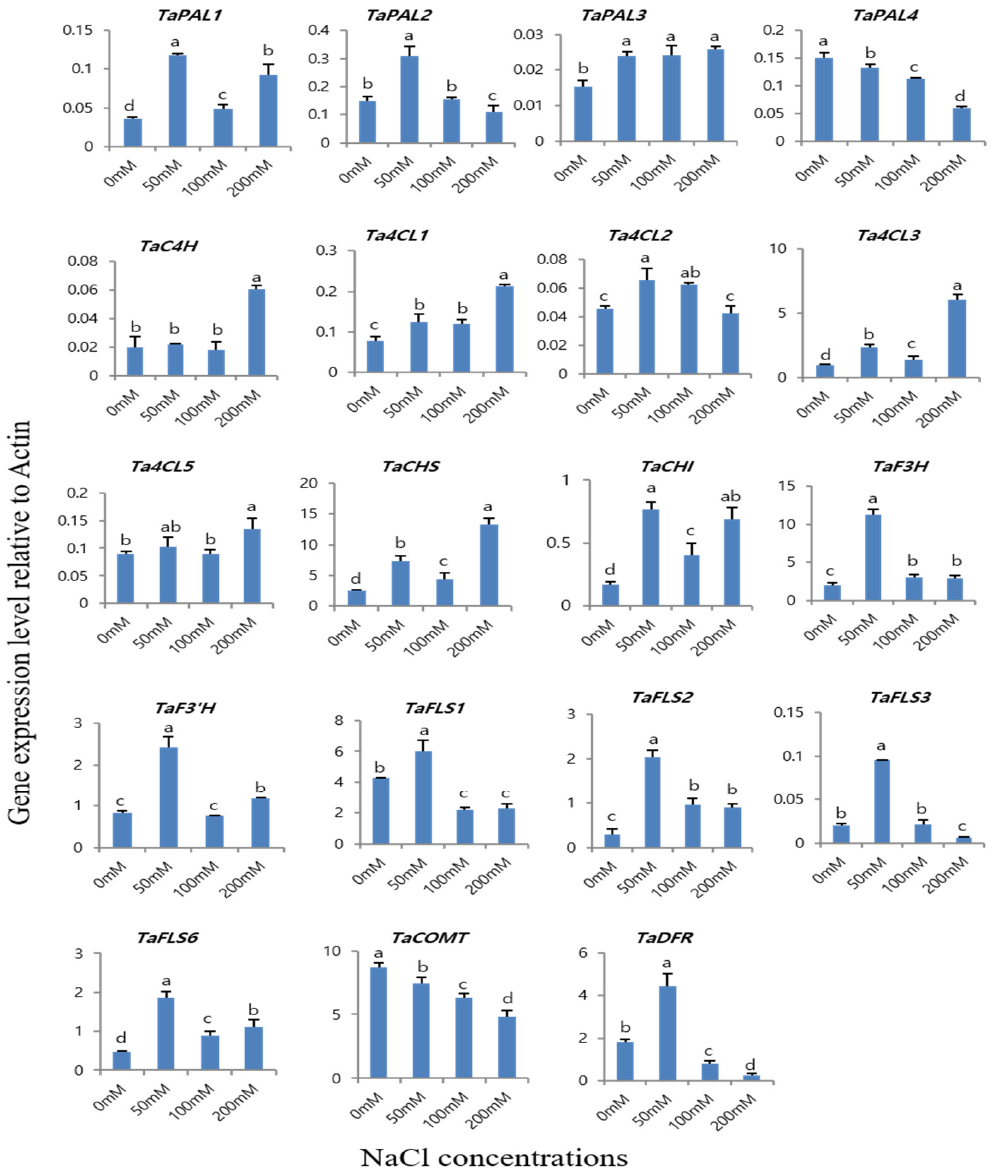
Figure 3. Relative expression levels of phenylpropanoid biosynthetic pathway gene in 6-day-old wheat sprouts grown under different NaCl concentrations. The means and SD were calculated from three biological replicates. Letters a-d denote significant differences ( P < 0.05).